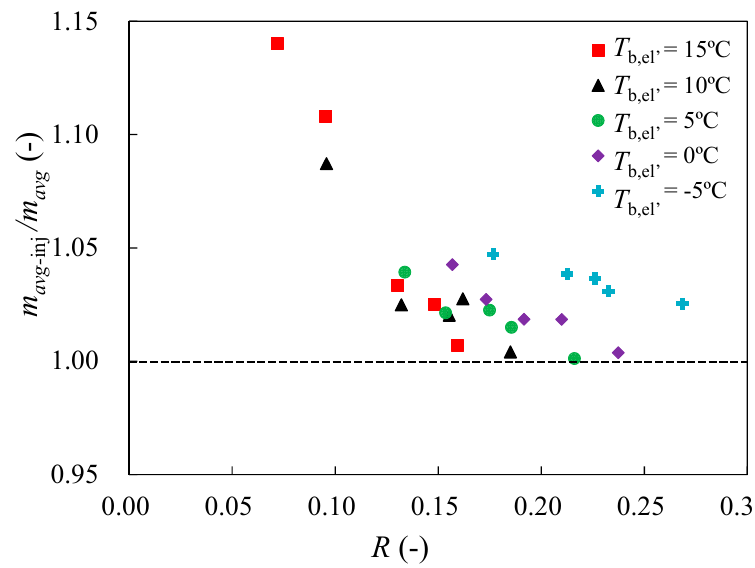
. . m avg-inj / m avg with the injection ratio R in